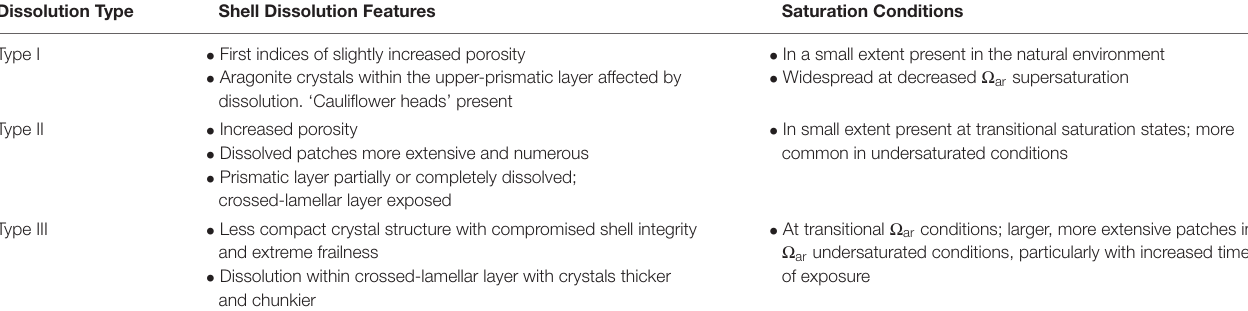
TABLE 1 | Descriptive features of pteropod shell dissolution stages and associated saturation conditions as described in Bednaršek et al. (2012b).